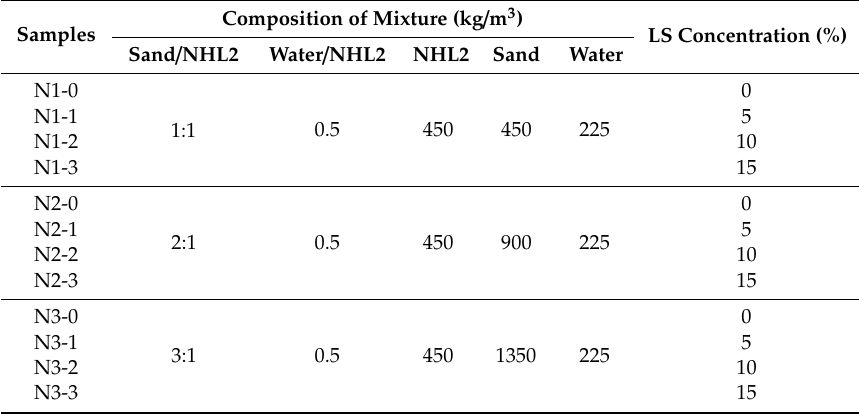
Table 2. The mix design of NHL-based